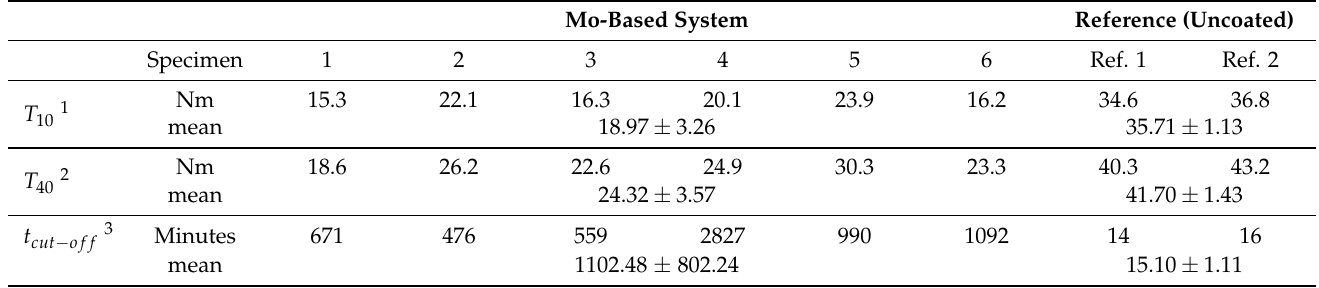
Figure 5. Frictional torque curves of the tribological investigations of the molybdenum-based coating systems: ( a ) Frictional torque development of the experiments as an overview ( n = 6) over time. ( b ) Higher time resolution of the Mo experiments. Detailed diagram of blue area from ( a ). ( c ) Time trend of the tests limited to the first 40min and a comparison of the molybdenum system and the reference tests. Table 3. Experimental overview and comparison of the Mo-based and Reference